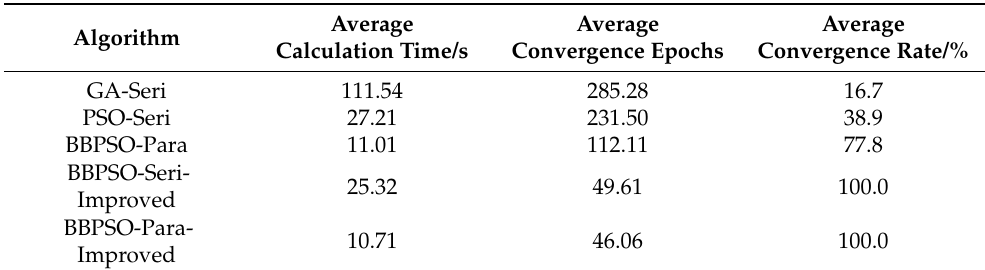
Table 1. Performance of five algorithms.